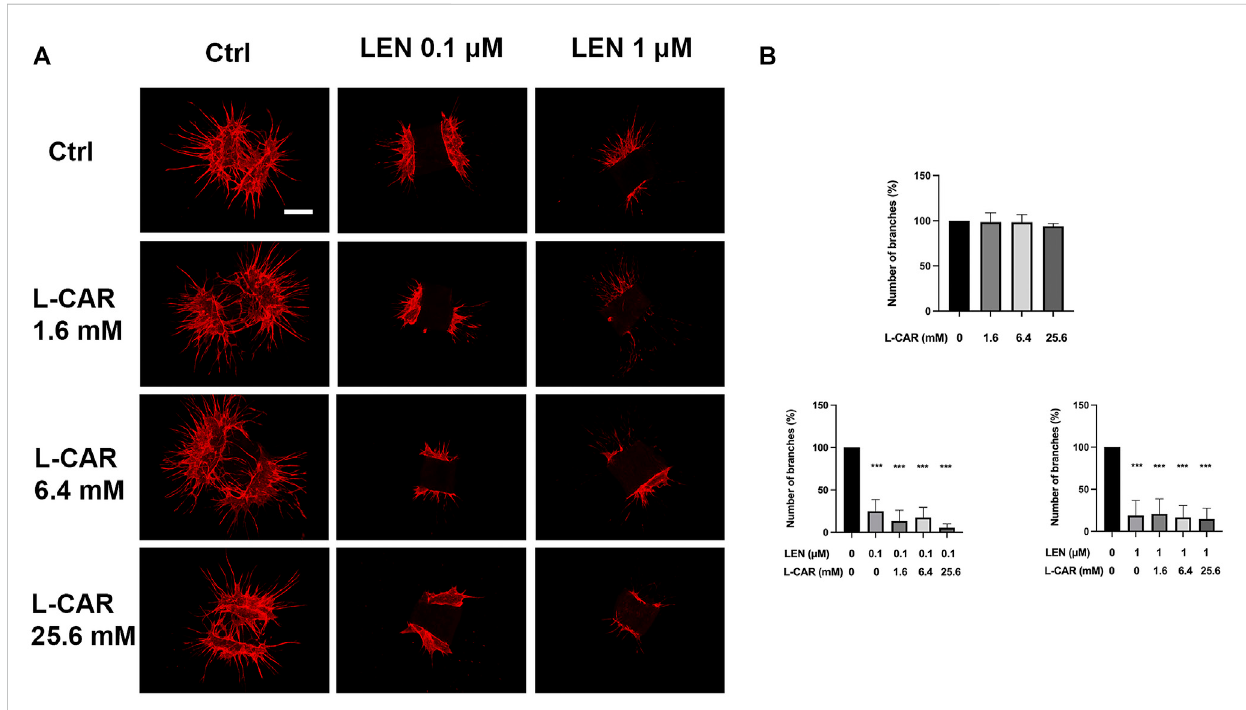
FIGURE 10 Effectsoflenvatiniband/orL-carnitineonbranchformationinmouseaorticringassay.Aorticringsembeddedinacollagenmatrixweretreatedwith lenvatinib (0.1or 1 µM), L-carnitine(1.6,6.4, or25.6 mM),and/or vehiclefor 7 days. Thereafter, theringswere cultured withoutanytreatment for another 6 days. The ImageJ software was used to identify and quantify the number of branches. (A) Representative images of tube formation. The white bar indicates 0.5 mm. (B) Data are presented as the mean +SD ( n = 3 from three independent experiments). *** p < 0.001 vs . Ctrl